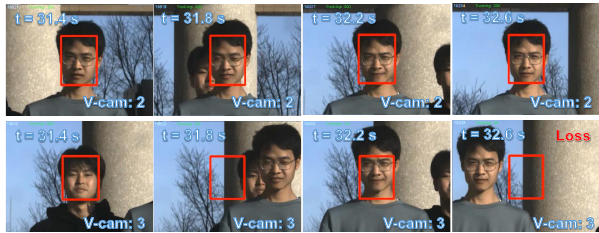
Figure 20. Cross-tracking of person 2 and person 3 between 31.4 and 32.6